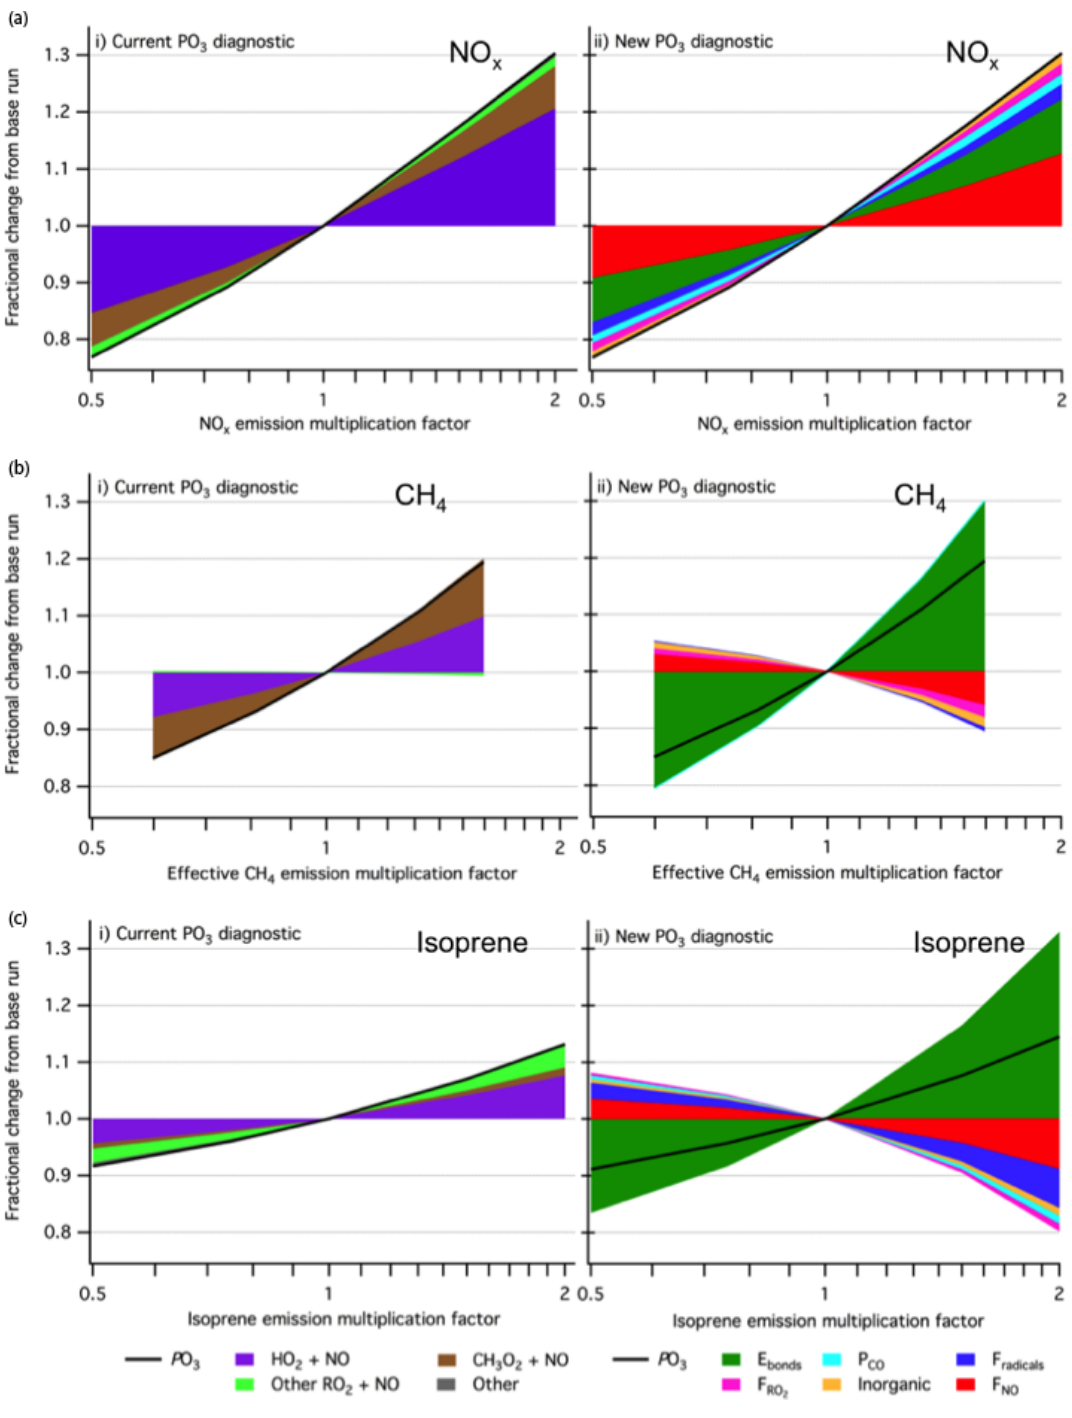
Figure 4. Understanding the effect of NO x and VOC emissions on ozone production at the process level. Stack plots showing fractional change in model P O 3 compared to base simulation and associated contributions from the current P O 3 (i) and new P s O 3 (ii) diagnostic parameters under changing NO x emissions (a) , effective CH 4 emission (b) and isoprene emission (c) . The P s O 3 diagnostic parameters are derived for each model simulation using the diagnostic implementation described in Sect. 3 and the fractional change in each parameter from the base simulation